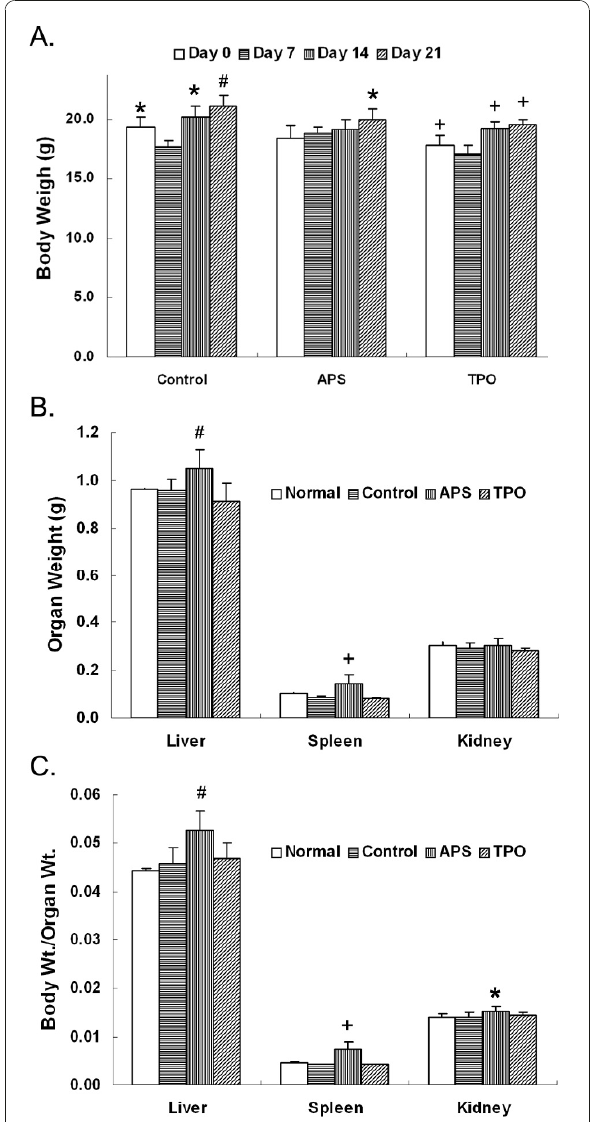
Figure 3 Effects of APS on the animal body size and organ size . Mice (n = 6) were irradiated on day 0 and then were treated with vehicle (Control), APS (50 mg/kg/day, APS) and TPO (5 ug/kg/ day, TPO) as described in Figure 2. Their body weight and organ size were then measured. Effects of APS and TPO treatments on the animal weight (A), organ size (B) and organ size normalized by body weight (C) are shown. The statistical tests were carried out on the measurements of samples treated with APS and TPO and those in the control group. For samples in the control group (A), the comparisons were carried out between those of days 0, 14 and 21 and those of day 7. *: p < 0.05; #: p < 0.01 and +: p <